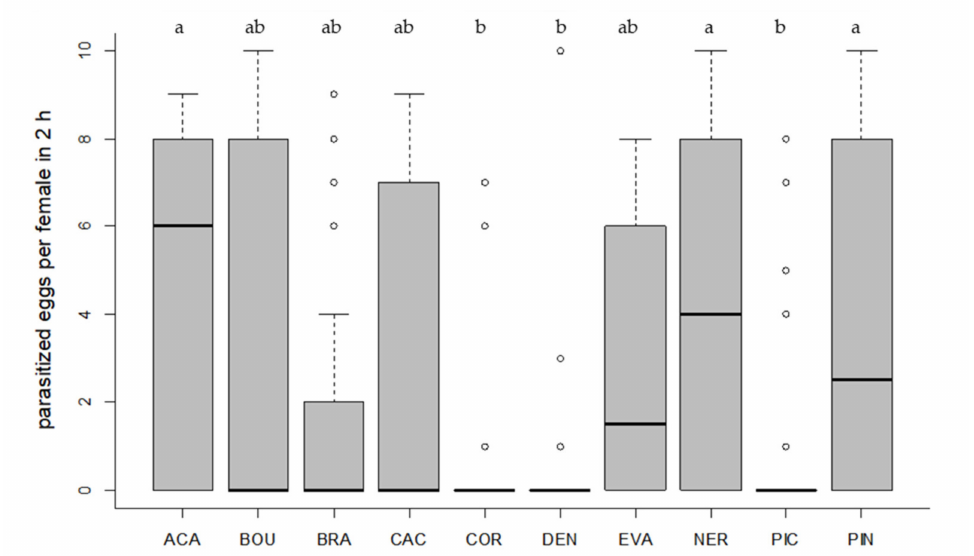
Figure 2. Number of parasitized T. absoluta eggs per parasitoid female. Ten eggs of the target host were o ff ered to each female in a no-choice test on tomato leaf discs for two hours. Box plots denote median (solid line), whiskers show range of data, and circles represent outliers. Di ff erent letters indicate significant di ff erences between Trichogramma strains ( p < 0.05, n = 30 females per